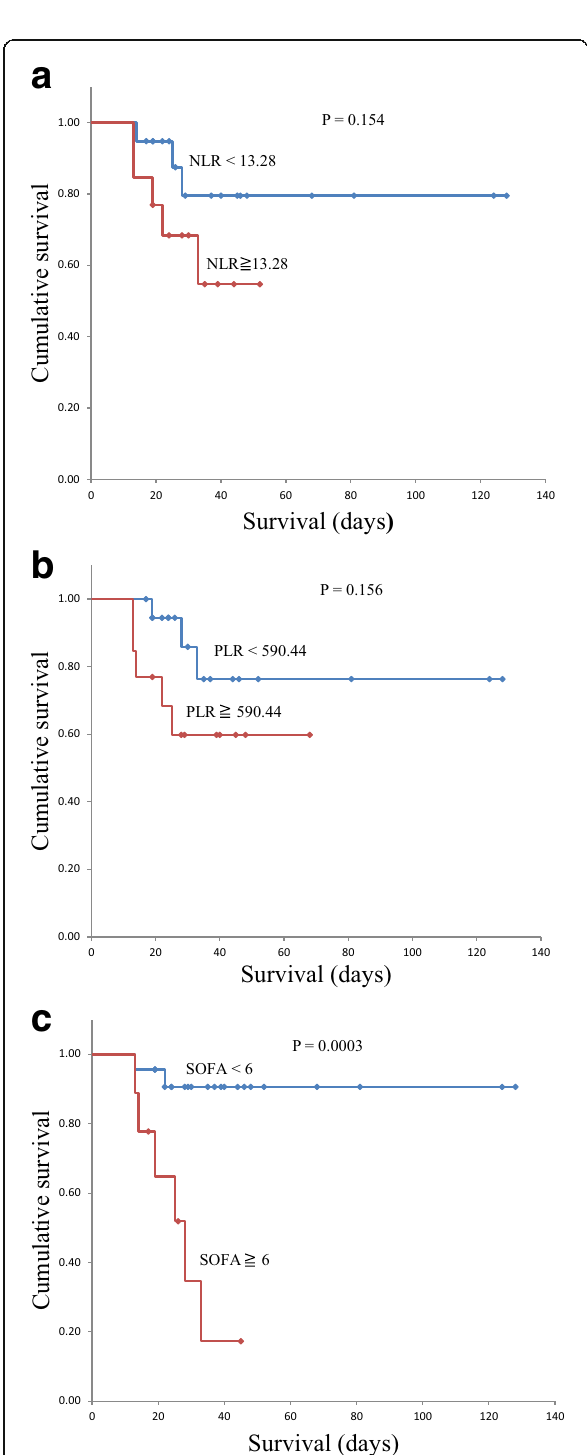
Fig. 2 Kaplan-Meier survival curves for inflammation-based prognostic scores. a NLR. b PLR. c